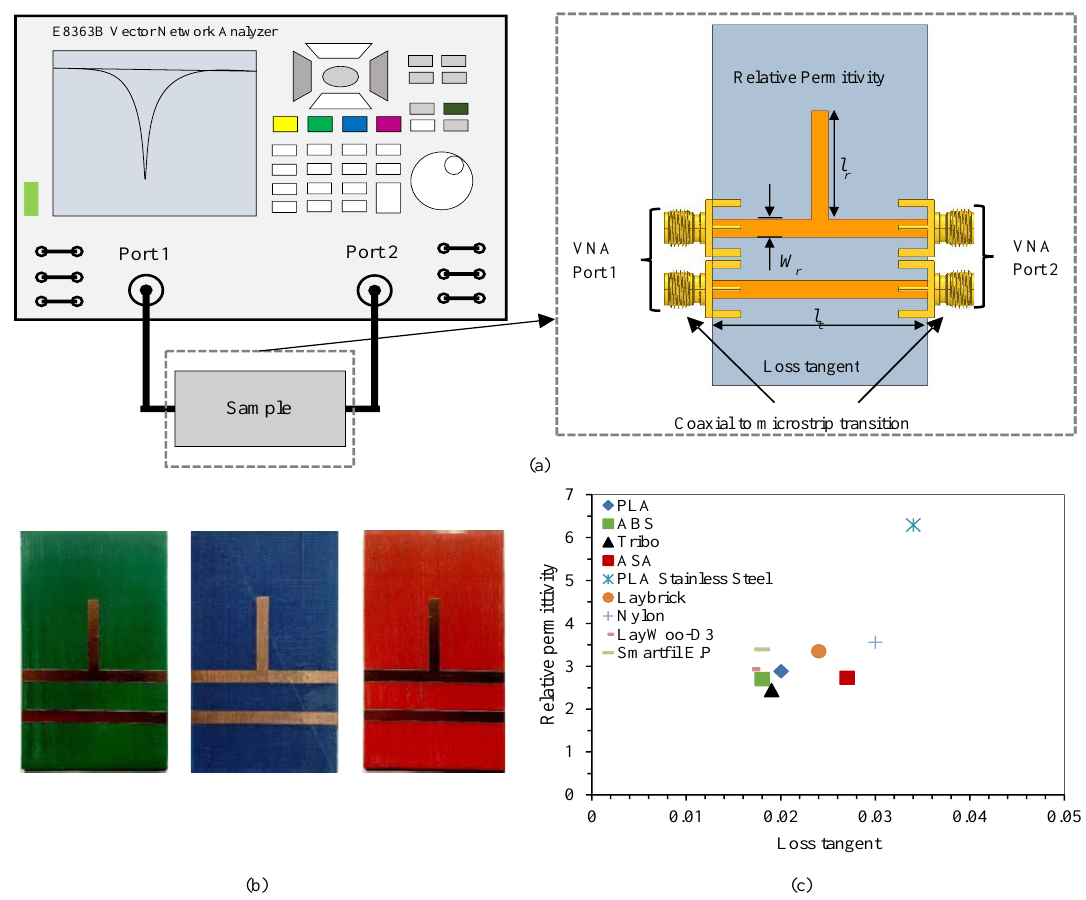
Figure 4. ( a ) Setup for the dielectric permittivity and loss tangent measurements. ( b ) Resonator and transmission line on different materials: Acrylonitrile Butadiene Styrene (ABS), PolyLactic Acid (PLA) and Acrylonitrile Styrene Acrylate (ASA). ( c ) Electrical characteristics calculated for different substrates.